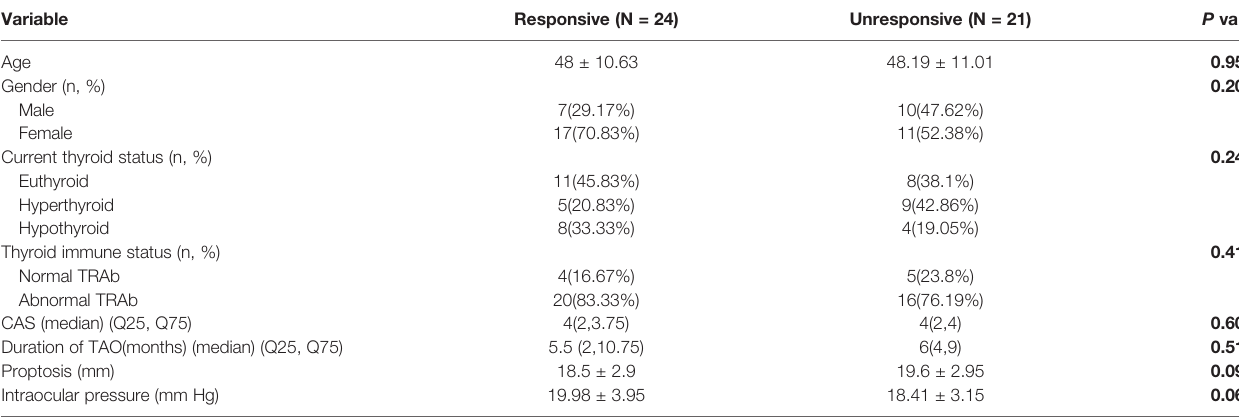
TABLE 1 | Univariate analysis of the clinical factors of TAO patients.